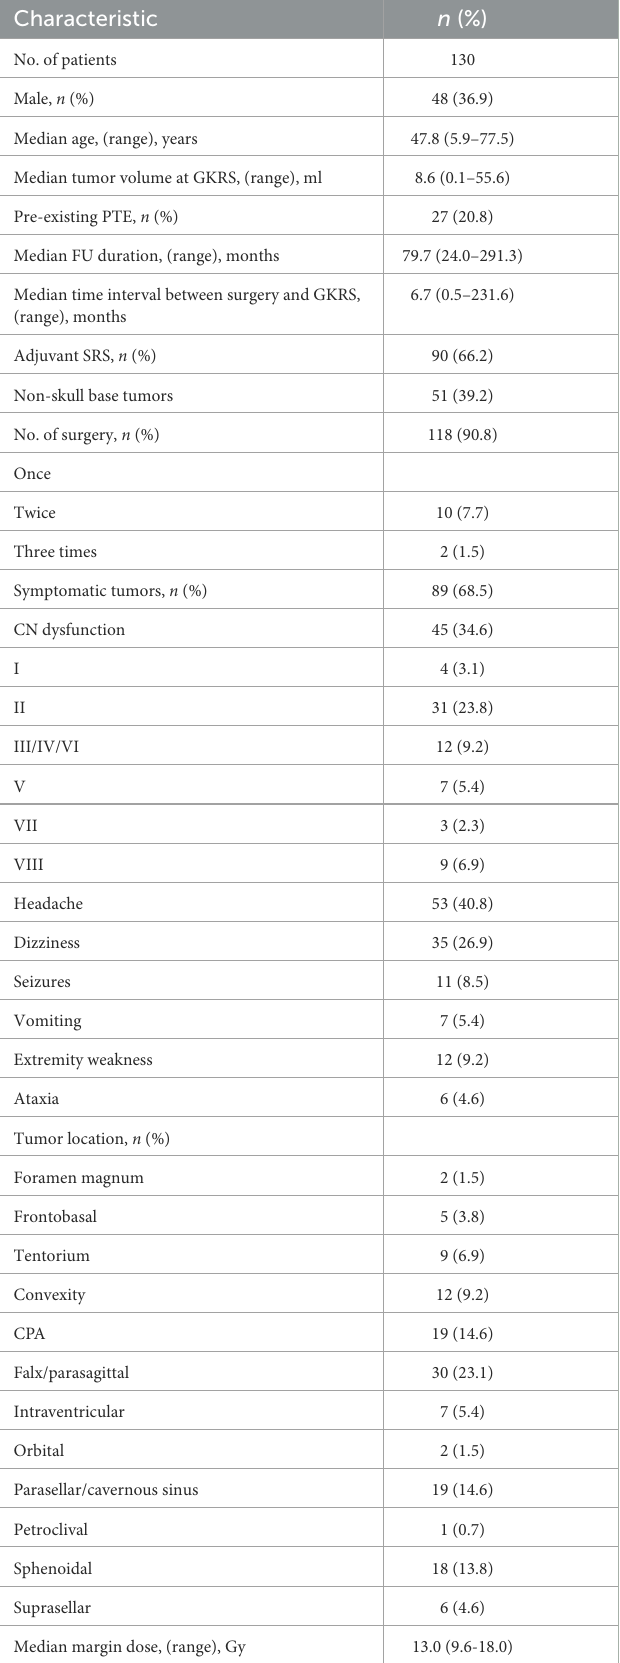
TABLE 1 Baseline and treatment characteristics of 130 patients with intracranial WHO grade I meningiomas treated with post-operative GKRS.